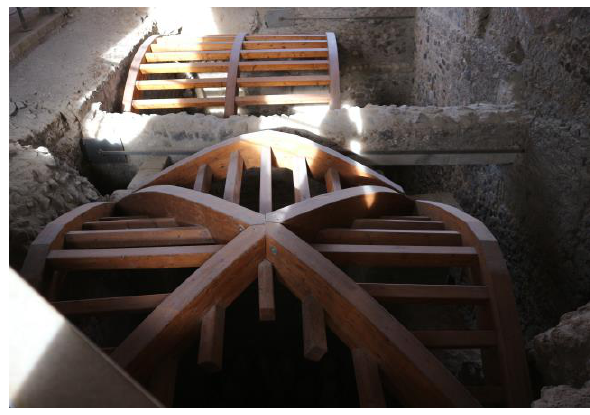
Figure 8. House of the Cryptoporticus, ‘praefurnium ’ roofed with a barrel vault and a cross vault made of laminated